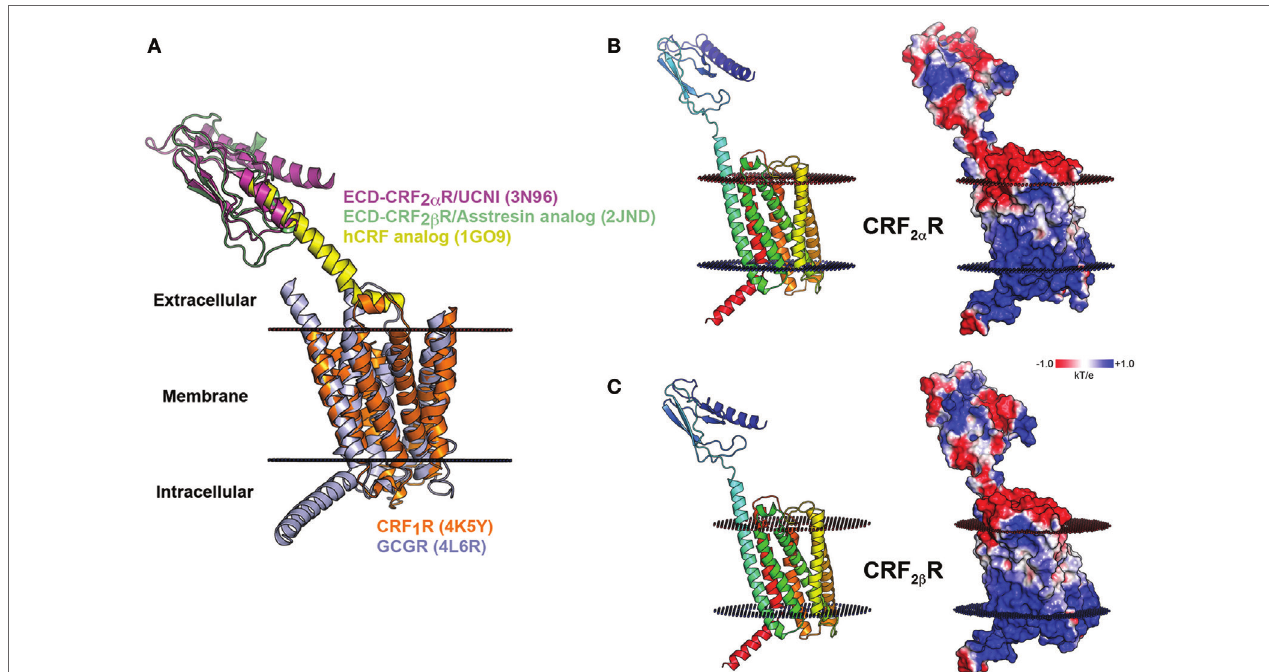
FigUre 4 | Molecular model of CRF 2 α R and CRF 2 β R. (a) Schematic representation of modeling of CRF 2 Rs generated based on the crystal structures of CRF 1 R and GCGR TM domains (orange and light blue, respectively) and the extracellular domain (ECD) of CRF 2 α R (magenta) and CRF 2 β R (light green) in complex with corticotropin-releasing factor (CRF) (yellow) analogs. (B,c) . Modeling of CRF 2 α R (a) and CRF 2 β R (B) and the electrostatic potential surface plotted onto the solvent accessible surface ( ± 1 kT/e) for both receptors. The positive and negative electrostatic values are colored blue and red,